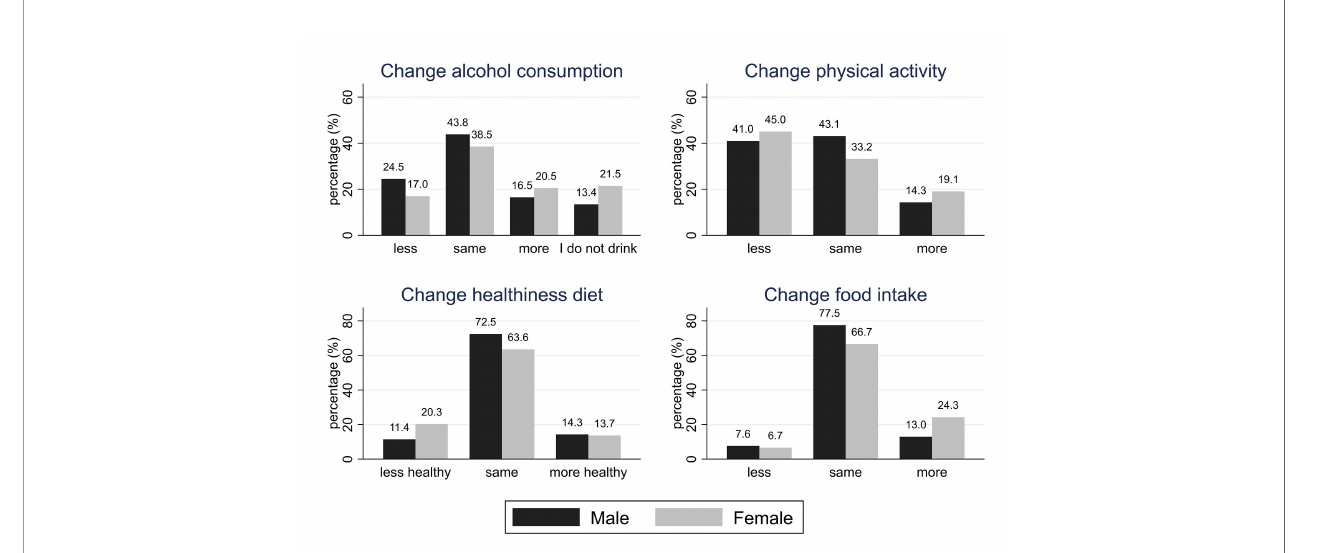
FIGURE 2 | Changes in lifestyle factors in HEAF